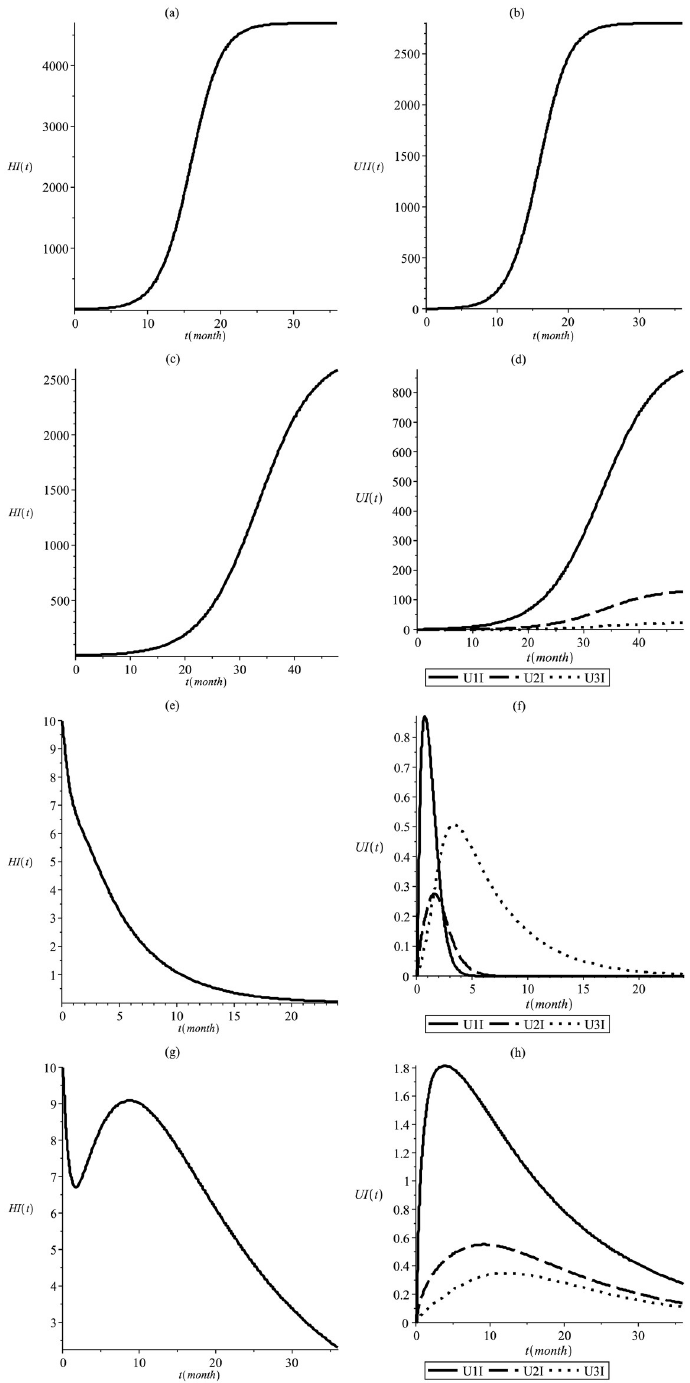
Fig 6. This simulation shows the infectious dynamics at T = 25˚C and p 1 = 0.3, p 2 = 0.4, p 3 = 0.3. Infectious human (a) and wild mosquitoes (b) in the absense of transgenic, resulting in R 0 = 2.43; infectious human (c) and mosquitoes (d) considering Mendelian inheritance and resulting in R Mend = 1.54; infectious human (e) and mosquitoes (f) considering MCR inheritance and without fitness cost resulting in R = 0.48; infectious human (g) and mosquitoes MCR (h) considering MCR inheritance and fitness cost resulting in R MCR =